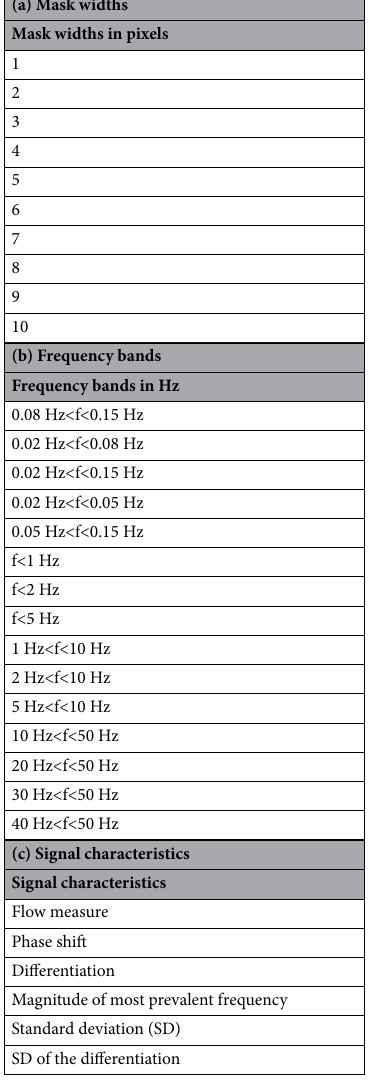
Table 3. Signal variables in form of widths of the masks representing section cuts, the frequency bands used for band-pass filtering and the signal characteristics